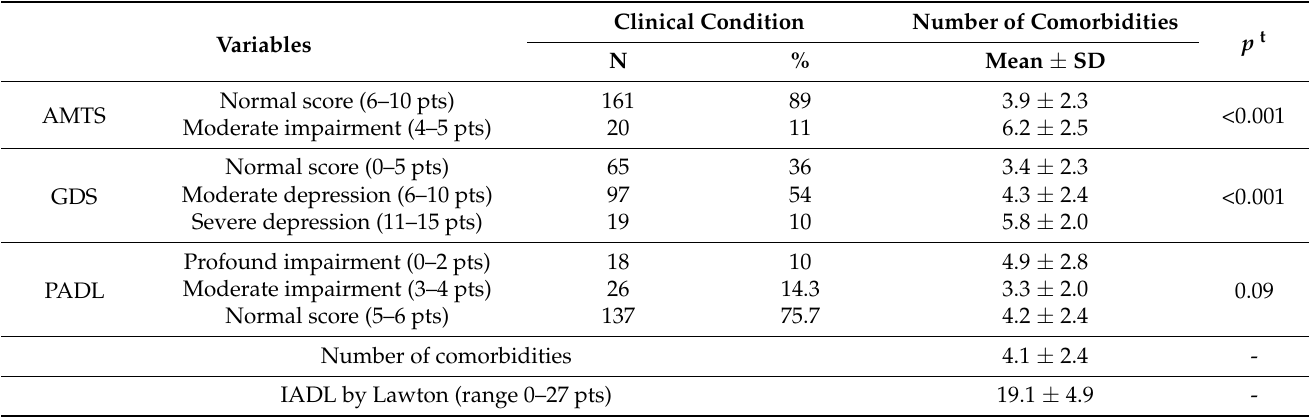
Table 1. Clinical status conditioned by the number of coexisting